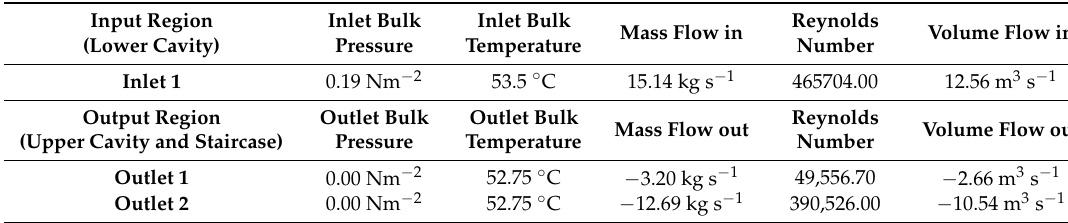
Table 3. Characteristics of input and output regions.